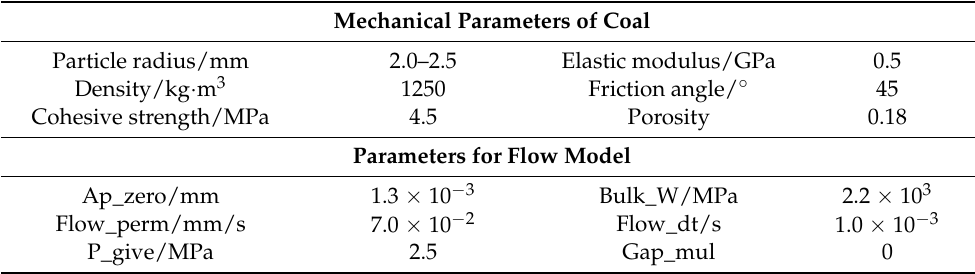
Figure 3. Variation curves of vertical stress and AE impact number of coal sample during uniaxial compression. The red and black lines represent the AE number and the stress-strain curve, respectively. The upper left corner figure is the failure figure of laboratory and simulated respectively. Table 1. Microparameters of numerical model.